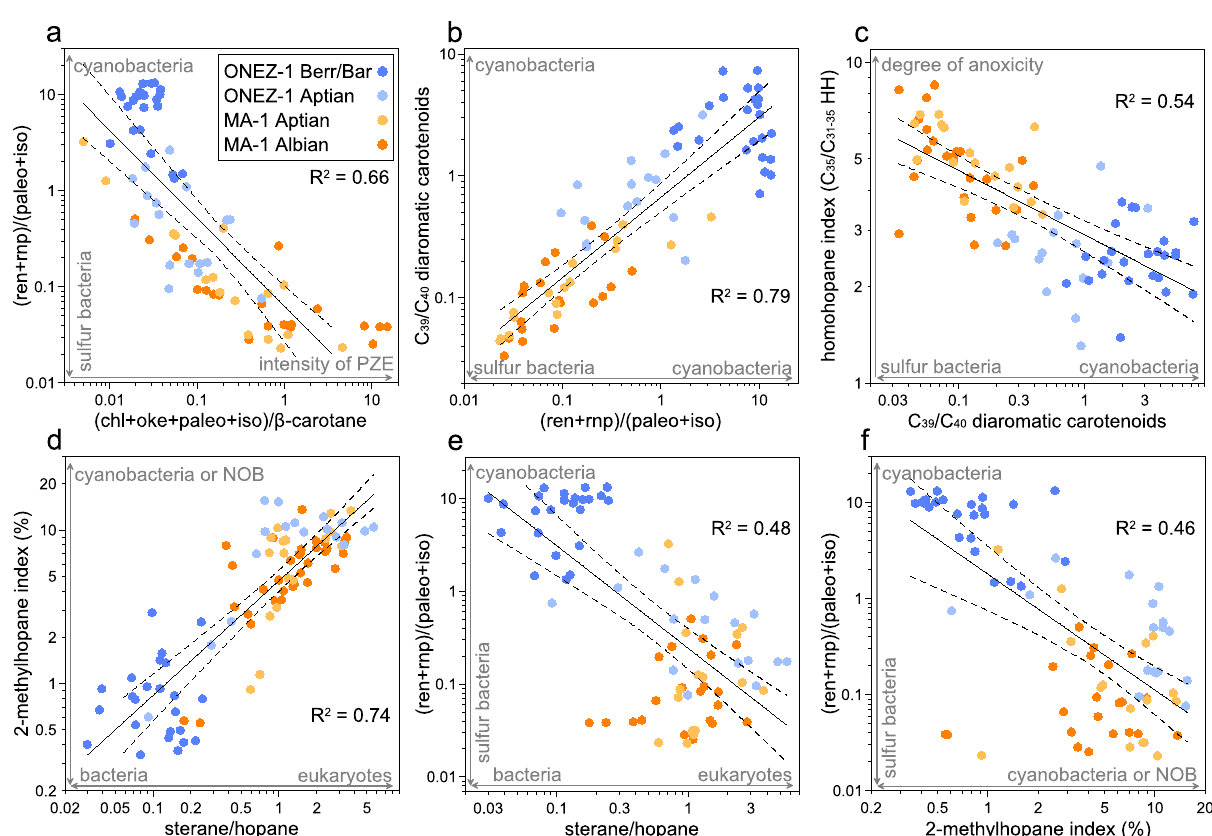
Fig. 5 Cross-plots of selected depositional environment and microbe-related biomarker proxies. a , b are correlations of carotenoid-derived proxies. c Homohopane index versus the ratio of C 39 /C 40 diaromatic carotenoids. d 2-Methylhopane index plotted against the ratio of sterane/hopane. The ratio of (ren + rnp)/(paleo + iso) versus ( e ) the ratio of sterane/hopane and ( f ) 2-methylhopane index. Samples are separated into the four groups described in the text. The inferred meaning of each ratio, explicitly (ren + rnp)/(paleo_iso) 24,39 , (chl + oke + paleo + iso)/ β -carotane 26 , C 39 /C 40 diaromatic carotenoids 21,39 , homohopane index 30 , 2-methylhopane index 33 , and sterane/hopane 27 , is annotated with gray arrows and labels. The solid line and dashed lines represent best fi tting curves and 95% con fi dence